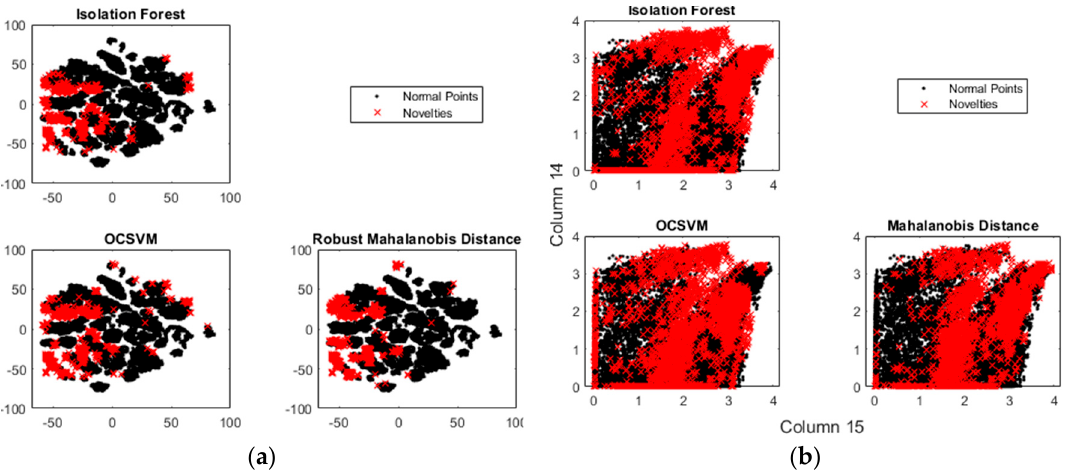
Figure 8. ( a ) Detecting abnormalities in the contaminated pHRI-ADL data, ( b ) ranking features. Table 7. Data contamination .